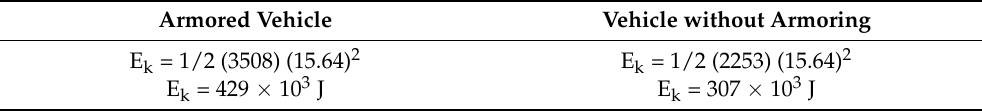
Table 3. Comparison of the kinematic energy between the armored vehicle and the vehicle without armoring.